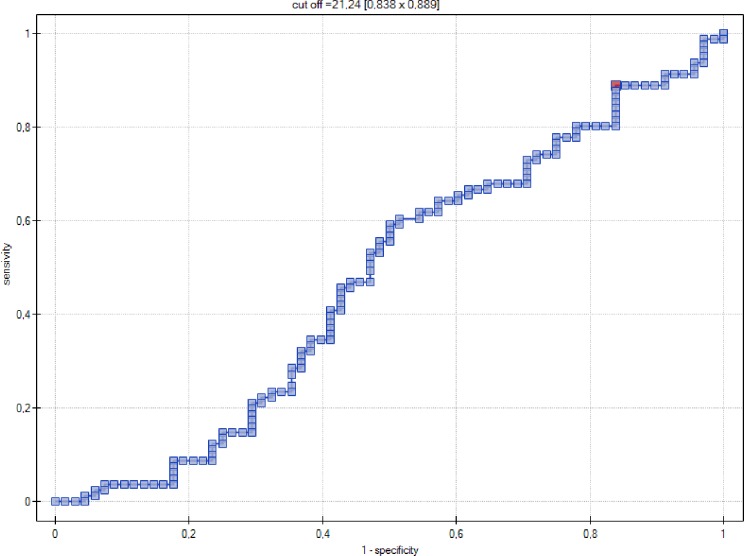
ROC curve–relationship between NT-proBNP levels (pg/ml) and occurrence of gestational diabetes mellitus.